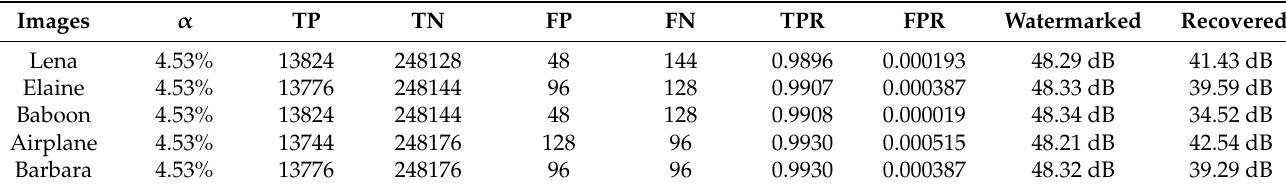
Table 3. Tamper localization and recovery analysis against copy-paste attack